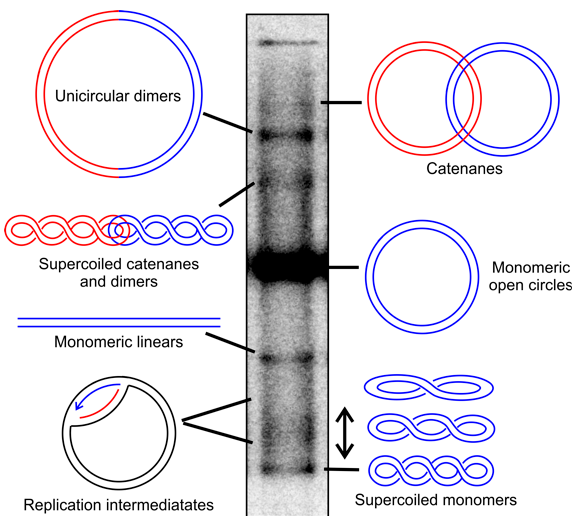
Figure 1. Topological conformations of human mitochondrial DNA (mtDNA). The different topological conformations of mtDNA can be separated by agarose gel electrophoresis in the absence of DNA-intercalating dyes and visualized by Southern blotting. Supercoiled mtDNA molecules can be converted into relaxed forms by treatment with Top1, while catenanes can be separated by TopIV. The treatment with restriction enzymes in a single recognition site in mtDNA creates monomeric linears of all circular molecules, as well as dimers. Replication intermediates decrease in cells treated with ciprofloxacin due to the reduced replication initiation, while replication stalling leads to their accumulation. Blue and red colors are used to visualize individual molecules, and in the case of dimers, the typical genome length of mtDNA. For the detailed treatment conditions and visualization, please see [38,39].